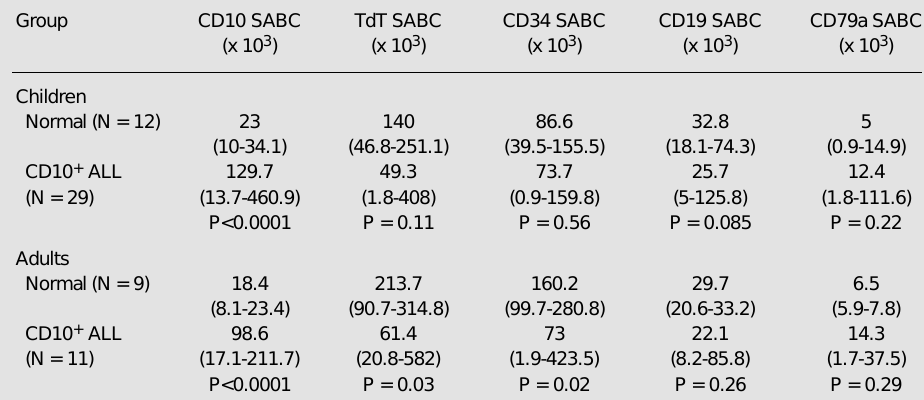
Table 3 - Analysis of CD10, TdT, CD34, CD19 and CD79a SABC values in normal and leukemic bone marrow precursors of children and adults. Data are reported as median (1st-99th percentiles ). P values were calculated by the Mann-Whitney U-test. ALL, Acute lymphoblastic leukemia.